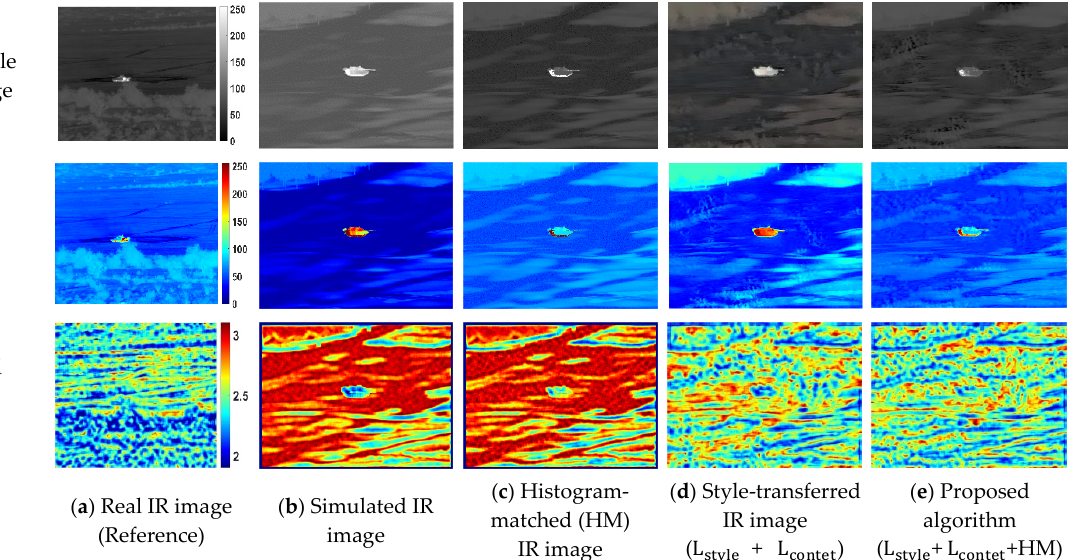
Figure 4. Results of grayscale infrared image, false-colored infrared RGB image, and fractal RGB image in each of the three simulation conditions: ( A ) Cloudy summer weather at 20 h; ( B ) Fine summer weather at 20 h; ( C ) Cloudy summer weather at 10 h with four different image generation techniques: ( a ) Real infrared image as a style reference; ( b ) Simulated IR images; ( c ) Histogram-matched (HM) IR images; ( d ) Neural style transferred IR images; ( e ) Proposed histogram-matched neural style transferred IR